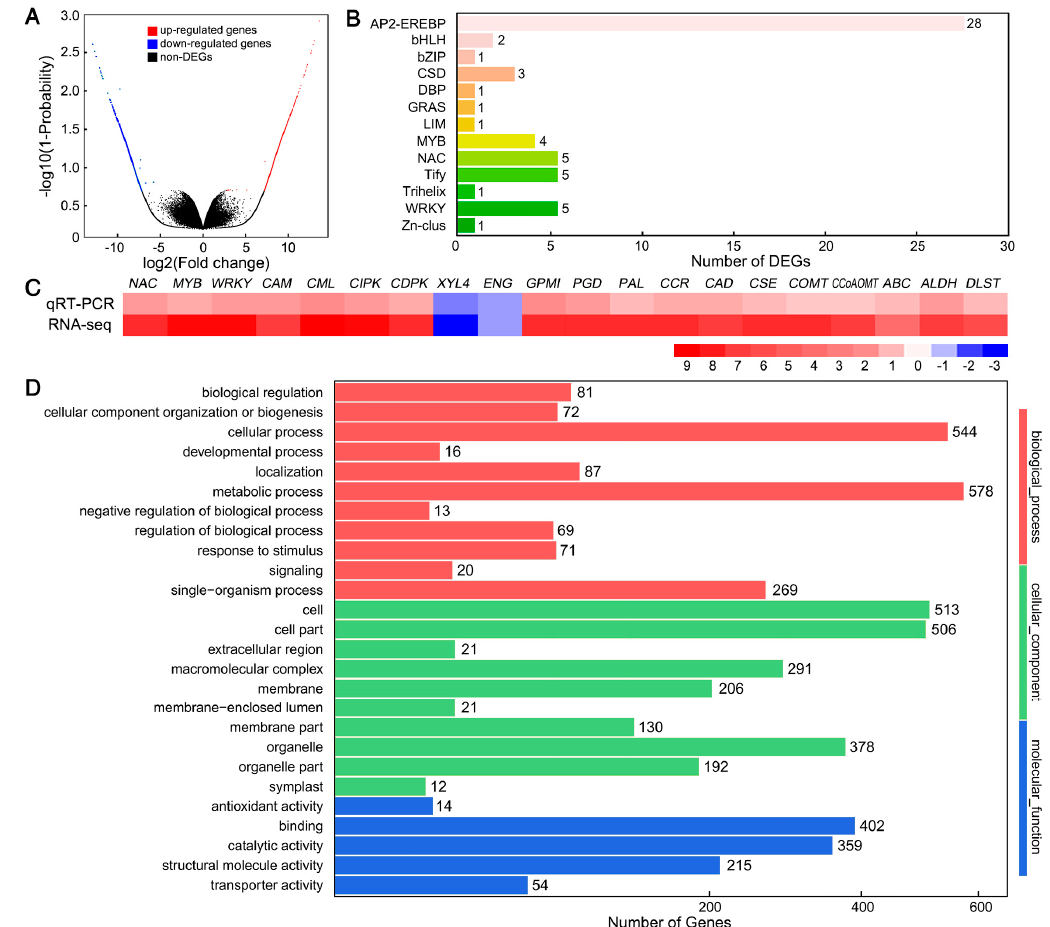
Figure 2. Effects of nano-CaCO 3 treatment on the transcriptome of P. lactiflora inflorescence stems. ( A ) Volcano plot of differentially expressed genes (DEGs). The X axis represents log2-transformed fold change, the Y axis represents -log10-transformed adjusted p -values, the red points represent upregulated DEGs, the blue points represent downregulated DEGs, and the black points represent non-DEGs. ( B ) Transcription factor family classification of DEGs. The X axis represents the number of DEGs and the Y axis represents the family of transcription factors. ( C ) Heat map of the log2 relative expression levels of the expression results for 20 DEGs in nano-CaCO 3 /Control obtained from RNA-seq and qRT-PCR analysis; CAM , Calmodulin gene; CML , Calmodulin-like protein gene; CIPK , calcineurin B-like protein-interacting protein kinase gene; CDPK , calcium-dependent protein kinase gene; XYL4, xylan 1,4-beta-xylosidase gene; ENG , endoglucanase gene; GPMI , 2,3-bisphosphoglycerate-independent phosphoglycerate mutase gene; PGD , 6-phosphogluconate dehydrogenase gene; PAL , phenylalanine ammonia-lyase gene; CCR , cinnamoyl-CoA reductase gene; CAD , cinnamyl-alcohol dehydrogenase gene; CSE , caffeoyl shikimate esterase gene; COMT , caffeic acid 3- O -methyltransferase gene; CCoAOMT , caffeoyl-CoA 3- O -methyltransferase gene; ABC , ABC transporters; ALDH , Alcohol dehydrogenase; DLST , Dihydrolipoamide succinyltransferase. ( D ) GO classification of DEGs. The X axis represents the number of DEGs, the Y axis represents the GO terms.